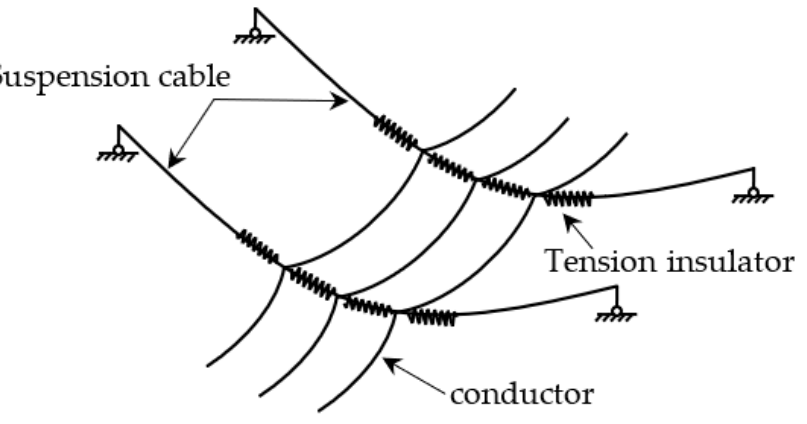
Figure 2. Diagram of long-span cross-rope suspension line.